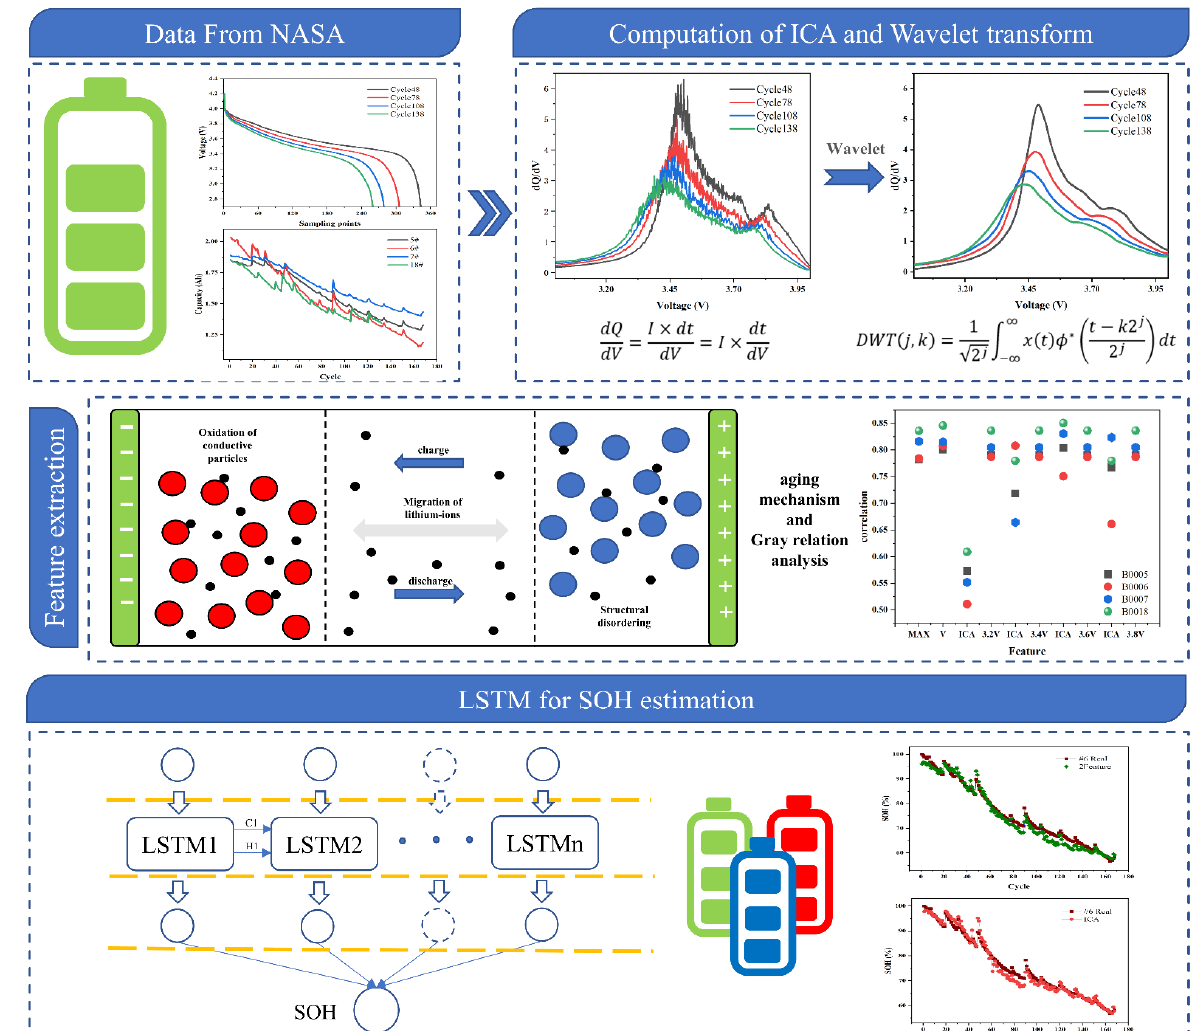
Figure 1. Flow diagram of SOH estimation.